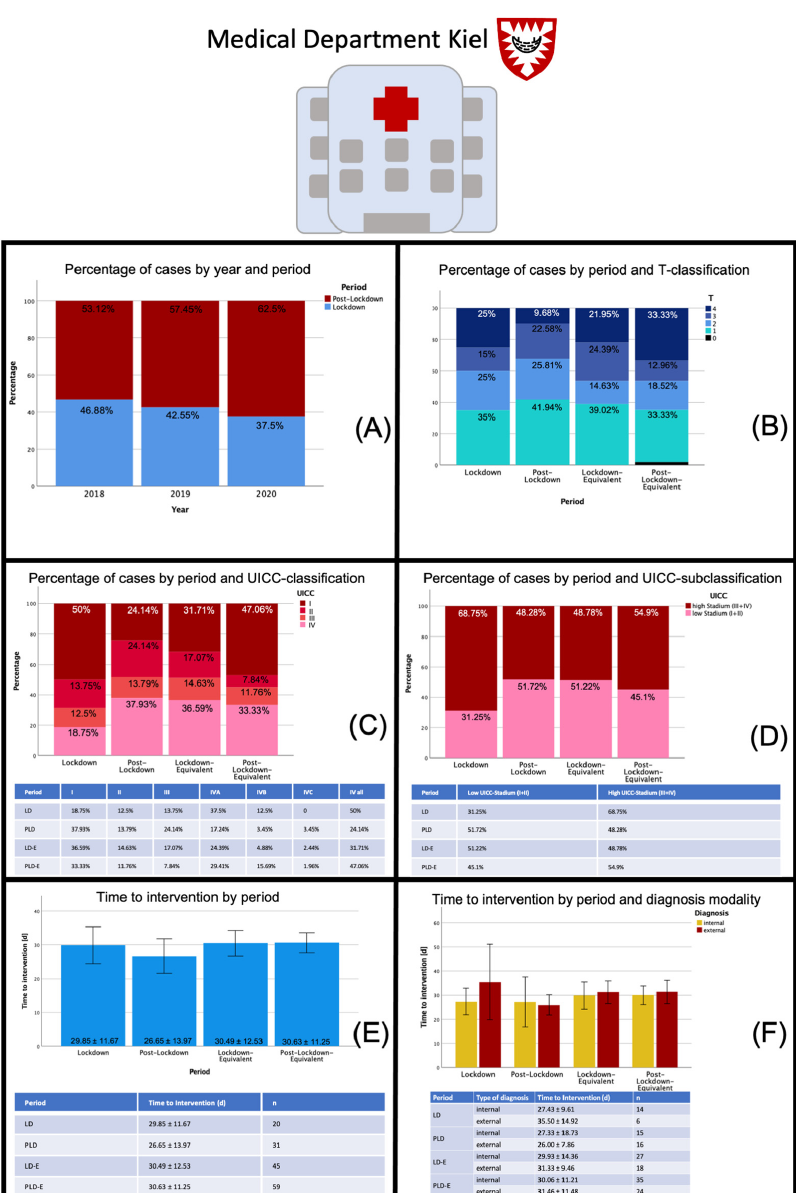
Figure 3. Data sheet Medical Department Kiel: Distribution of patients with oral malignant lesions by different periods, distribution of tumor stages (T-classification, UICC-classification) and time to intervention during the different periods. Abbreviations: LD—lockdown; PLD—post-lockdown; LD-E—lockdown equivalent; PLD-E—post-lockdown equivalent; UICC—Union international contre le cancer. In ( A ) cancer diagnoses per year and period are displayed (in percent) show-